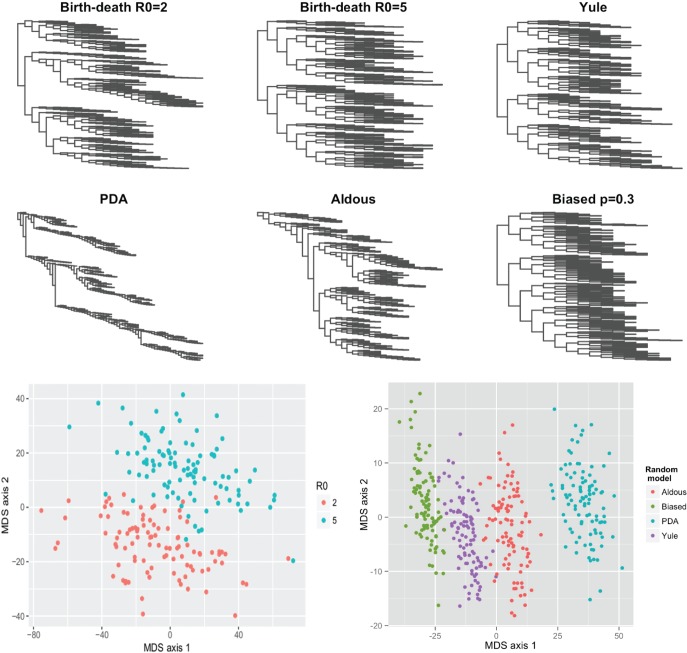
Top: Six sample trees, one from each of six different random processes. Bottom: Multi-dimensional scaling (MDS) plots showing that trees from each process are grouped together in the metric. Bottom left: trees from a BD model with different values of \documentclass[12pt]{minimal}
\usepackage{amsmath}
\usepackage{wasysym}
\usepackage{amsfonts}
\usepackage{amssymb}
\usepackage{amsbsy}
\usepackage{upgreek}
\usepackage{mathrsfs}
\setlength{\oddsidemargin}{-69pt}
\begin{document}
}{}$R_0=\lambda/\mu$\end{document}. Bottom right: trees derived from the Yule, PDA, Aldous and biased models, each with 500 tips.